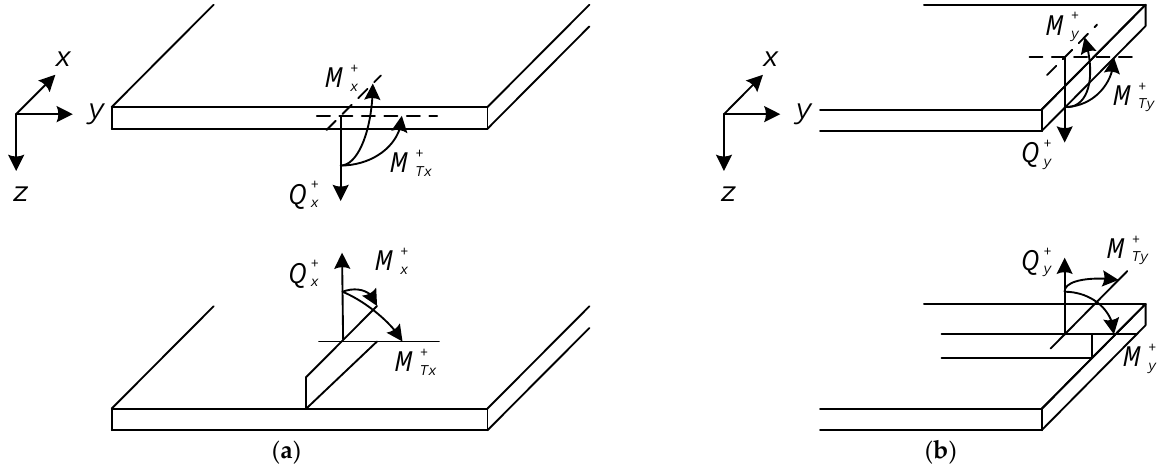
Figure 5. Conventions for torsional moments, bending moments and tensional forces between the upper panel and ( a ) x -wise; ( b ) y -wise rib-stiffeners.